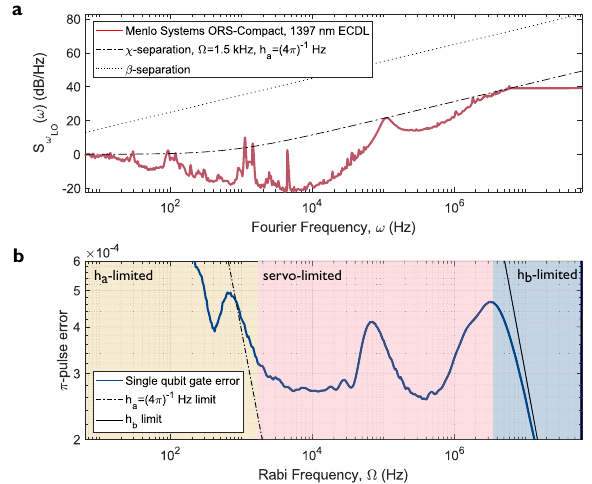
Fig. 4 Analysis of measured laser frequency noise using the χ - separation line. a Laser frequency noise of a Menlo Systems ORS- Compact at a wavelength of 1397 nm. The β -separation line indicates an ultra-narrow, sub-Hz linewidth. A χ -seperation line corresponding to the white noise at low Fourier frequency has been plotted, with a Rabi frequency chosen such that the high frequency noise is bounded by the line. b The calculated π -pulse error corresponding to driving an optical transition with the measured laser noise. The laser exhibits the three regimes of operation identi fi ed in our analysis, demonstrating that the χ -separation line is a useful tool for analysing real laser noise. noise. The χ − separation line for h a = (4 π ) − 1 Hz is plotted with the Rabi frequency of Ω = 1.5kHz, selected such that the high frequency noise falls below the line. The value of h a corresponds to the low Fourier frequency white-noise of the PSD. In Fig. 4b we calculate the π -pulse error for the Menlo laser driving an optical qubit transition over a range of typical Rabi frequencies. At low Rabi frequencies, the error approximately follows the h a -limit line ( h a -limited operation), before starting to plateau at around Ω = 1.5kHz as the high frequency noise crosses the χ − separation line (servo-limited operation). The slow integrator servo bump appears as an increased error rate for when ω srv ≈ Ω . At high Rabi frequencies, the error trends to the h b -limit ( h b -limited operation). This analysis shows that the χ -separation line is a useful tool for the analysis of laser sources even when spurs and bumps are present, and when there is a gradual, rather than step, transition between the stabilised and free-running noise. The demonstration that the χ -separation line is a useful tool for non-ideal frequency noise PSDs suggests that it can be applied to the cases of cascaded qubits even in the instance that their servo parameters are non-identical. In this case, the LO noise PSD -which is the summation of the individual, servoed noise PSDs - can be bounded by the χ − separation line. Each laser can then be optimised by reducing its individual contribution to any noise above the line that would then limit qubit fi delities. To determine the conditions under which the error from an h a - limited laser source is smaller than the fundamental SE error, we set the requirement ϵ SE > χ ( u ) /2. Here, ϵ SE is the spontaneous emission error (see Methods for de fi nition). In the asymptotic limit, ω → ∞ , this rearranges to the requirement srv